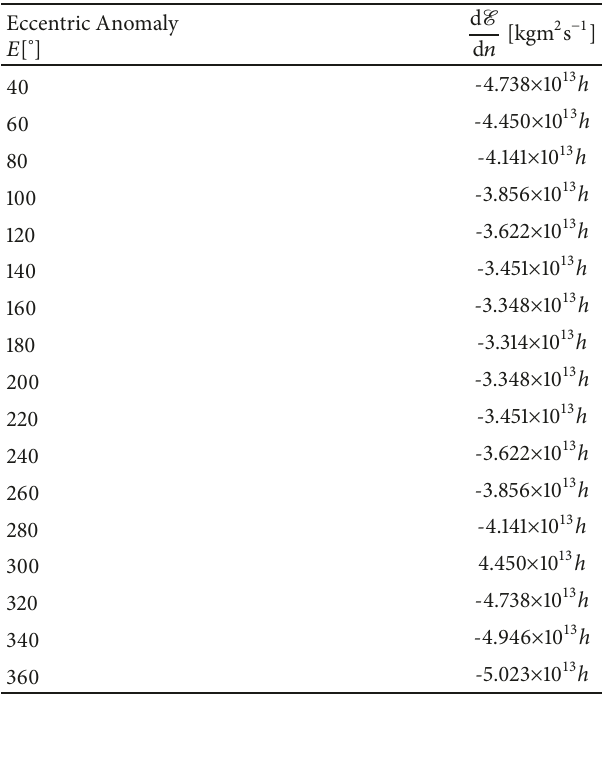
Table 1: Table of the rate d E / d 𝑛 as a function of eccentric anomaly for an elliptical orbit in a Yukawa potential.